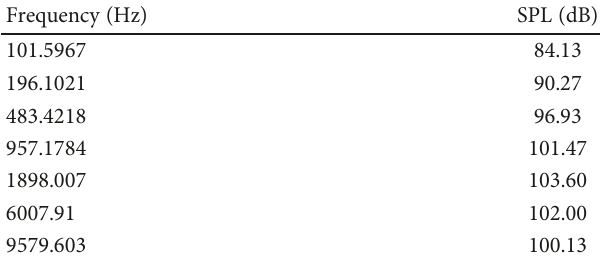
Table 4: Relative position symbol of measuring point and nozzle. Variable Signi fi cance R Length between nozzle and measuring point θ , theta Pole direction angle (angle between engine axis and line connecting measuring point and nozzle) ψ , psi Modi fi ed pole direction angle ( θ ) α , alpha Engine angle of attack (angle between engine axis and fl ight direction) Table 5: Subsonic jet noise spectrum experimental data [37].